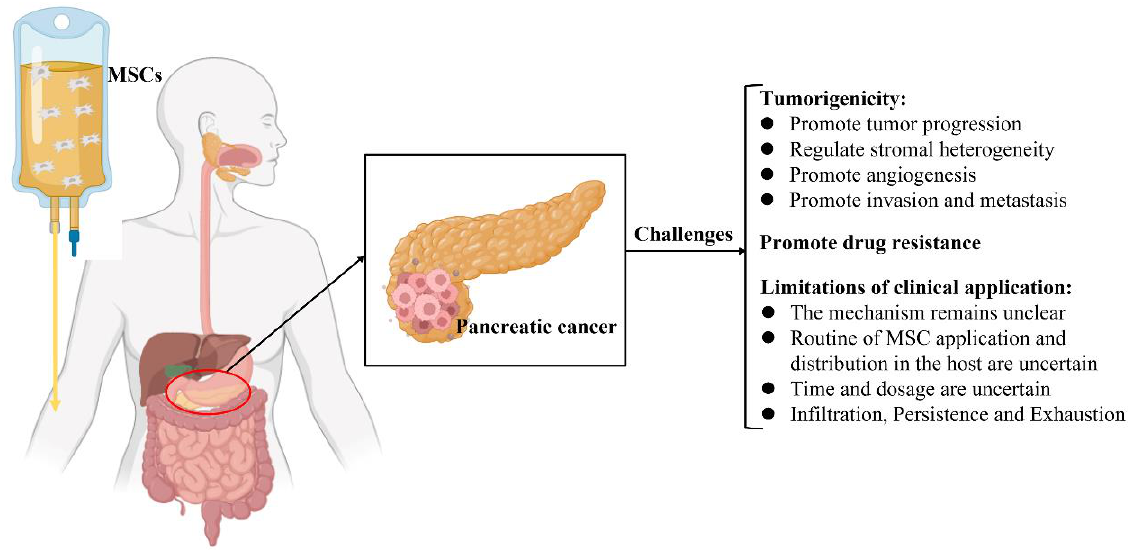
Figure 2. Schematic illustration of the current challenges of mesenchymal stromal cell treatment in pancreatic cancer.